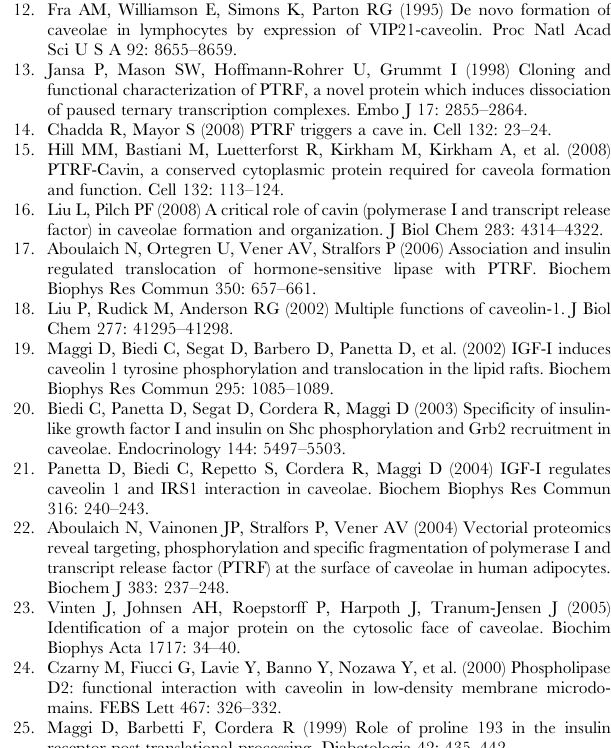
316: 240–243. 22. Aboulaich N, Vainonen JP, Stralfors P, Vener AV (2004) Vectorial proteomics reveal targeting, phosphorylation and specific fragmentation of polymerase I and transcript release factor (PTRF) at the surface of caveolae in human adipocytes. Biochem J 383: